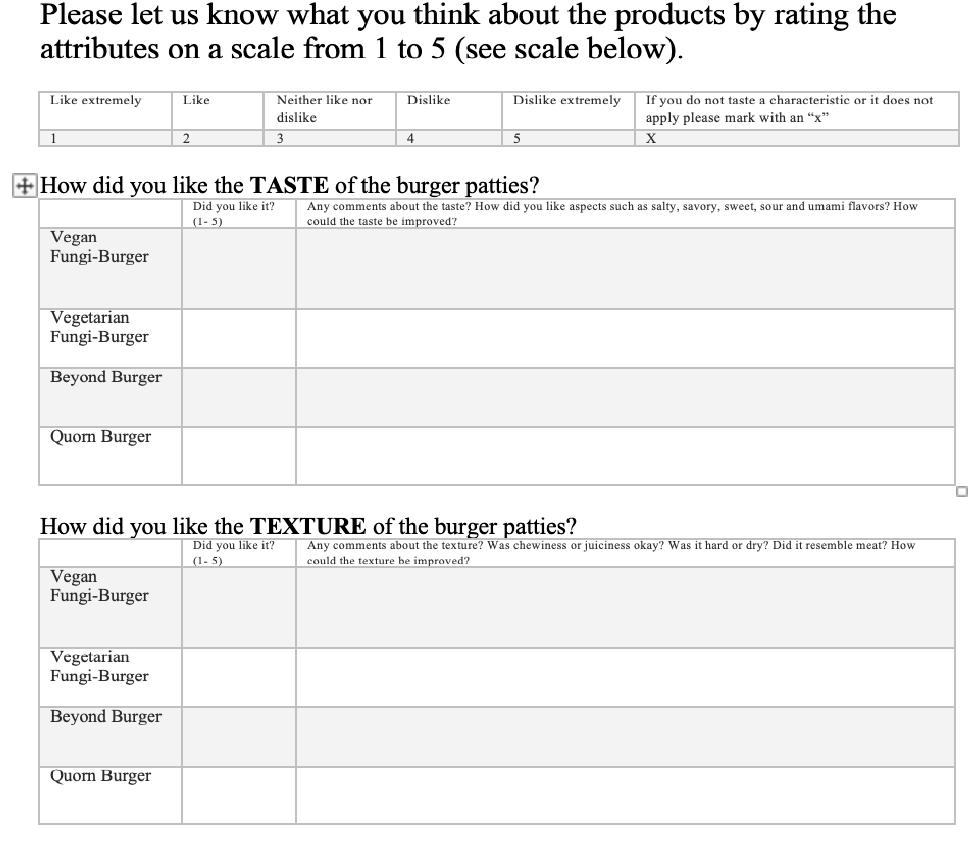
Figure A1. Questionnaire used in the sensory evaluation.